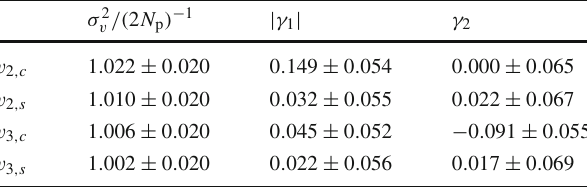
Table 4 Moments of the probability distributions displayed in Fig. 7 for the anisotropic flow harmonics in the initial state computed for 5000 events at b = 6 fm. The variance σ 2 v is divided by the rough estimate